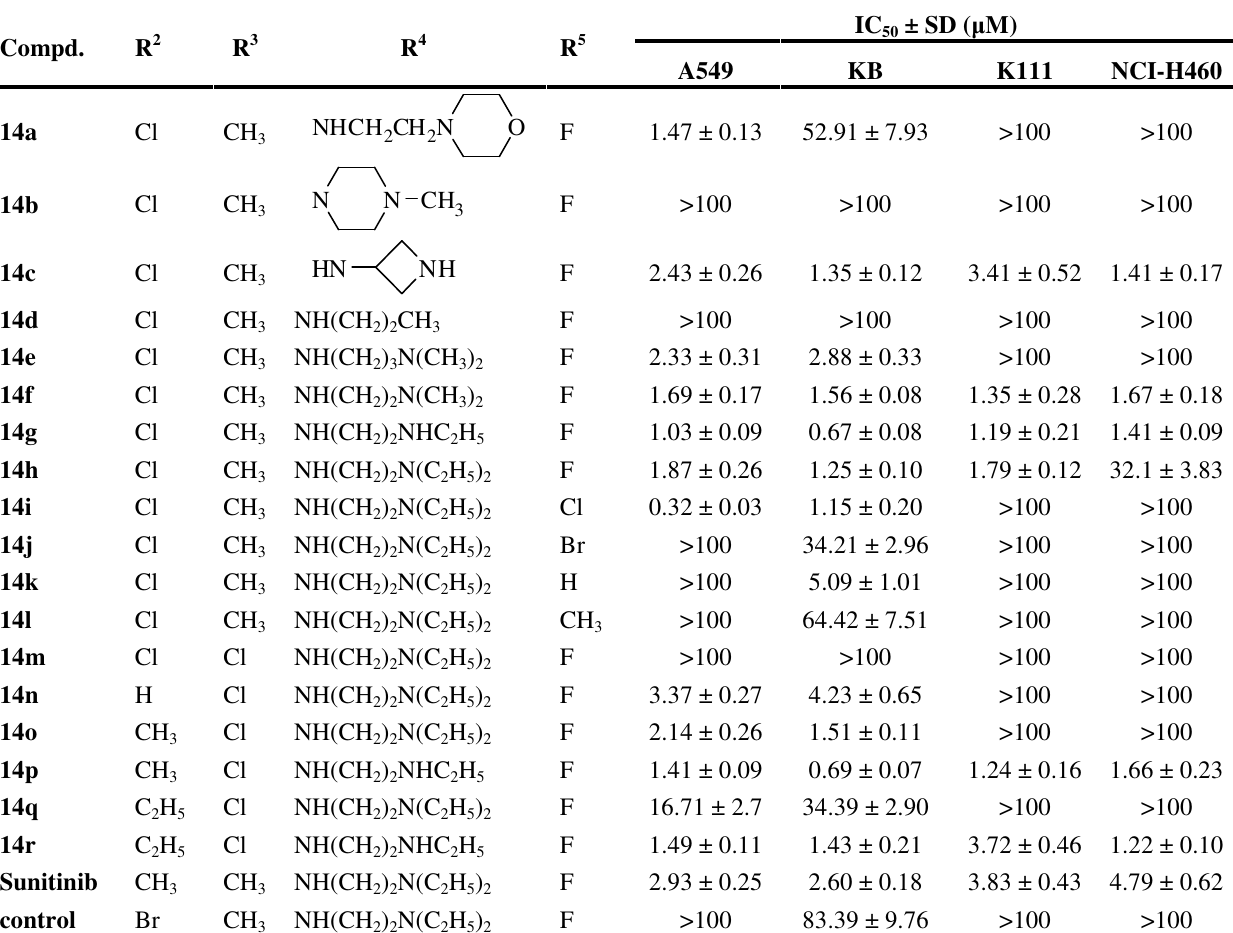
Table 1. Structures of compounds 14a–r and their antitumor activities on four tumor cell lines.